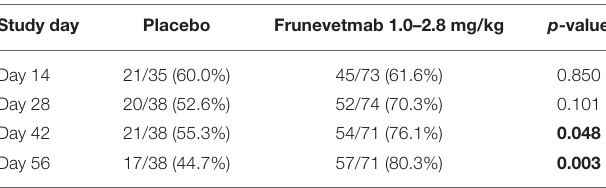
TABLE 2 | CSOM success rates for each treatment group and each evaluation time